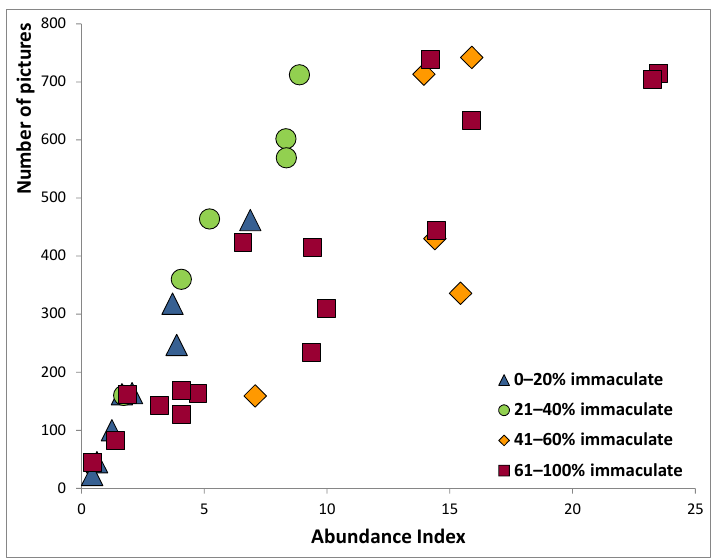
Figure A2. Relation between the average abundance of peacock butterflies in Belgium by week and the number of pictures submitted in that week differentiated for the average state of wear of butterflies in that week.